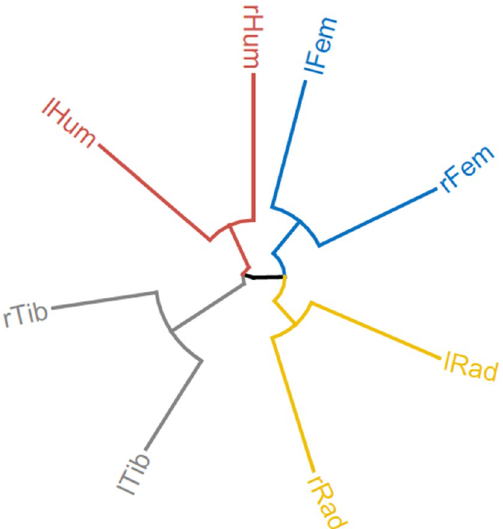
Figure 9. Hierarchical clustering of the selected variables from the second-order functions, intensity, and nearest-neighbour distance. A phylogenetic dendrogram was used. Four groups were identified (different colors) corresponding to each of the four elements analyzed. Key: lHum (left humerus); rHum (right humerus); lFem (left femur); rFem (right femur); lRad (left radius-ulna); rRad (right radius-ulna); lTib (left tibia); rTib (right